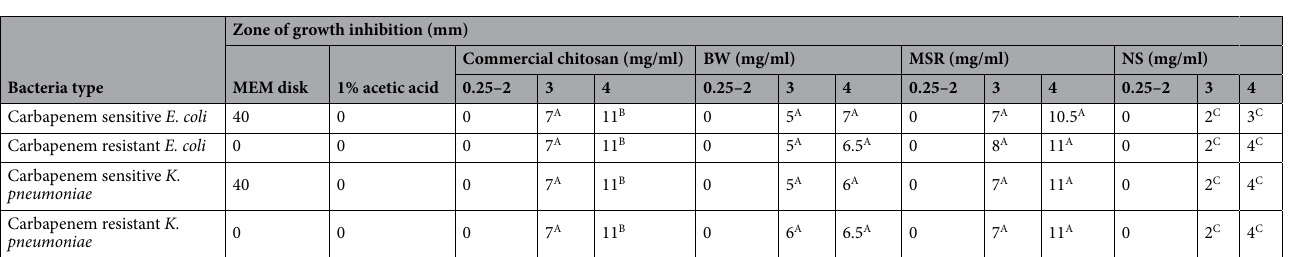
Table 4. Average growth inhibition zones of chitosan isolated from different sources. Meropenem (MEM) was used as a positive control while 1% acetic acid as a negative control. Mean values in each column accompanied by the same letter are not significantly different ( P > 0.05) (Tukey Multiple Comparison) and values accompanied by letter (s) which are not similar are significantly different ( P <